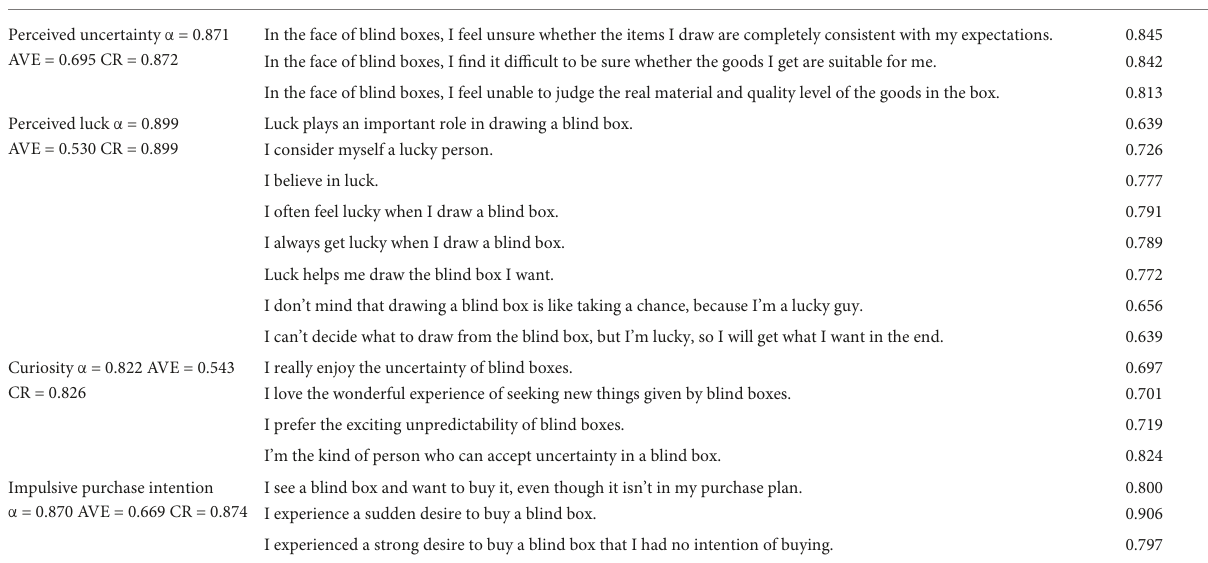
TABLE 3 Reliability and validity analyses of variables. Variable Items